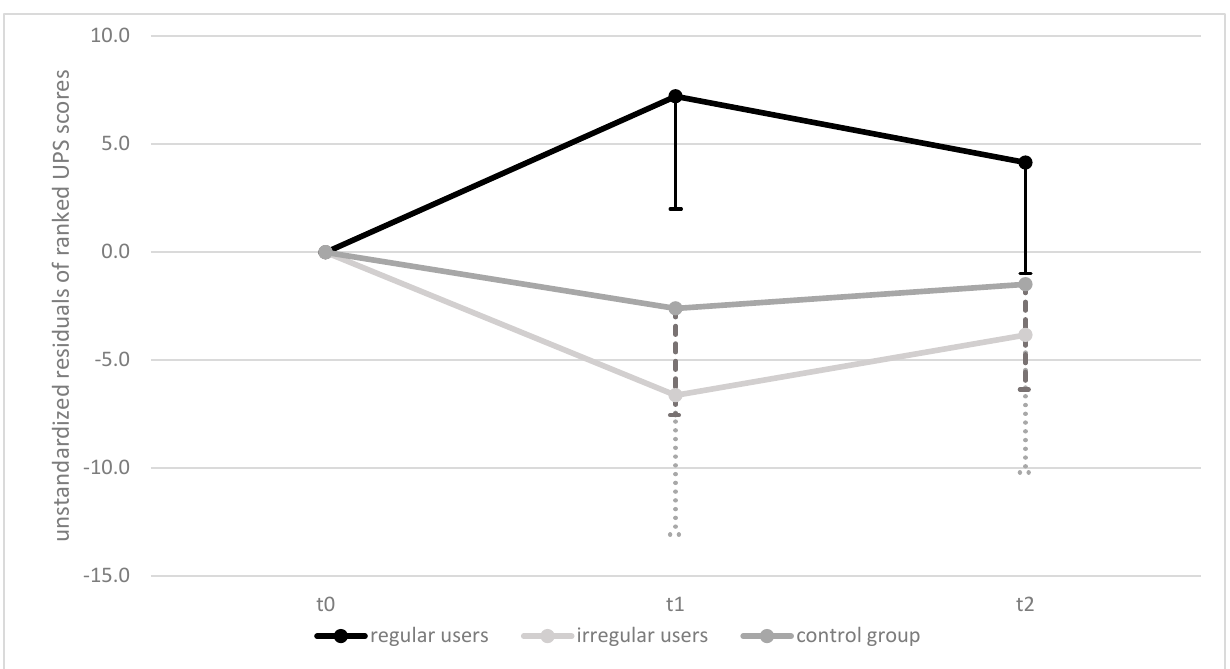
Figure 5. Mean Differences in UPS ANCOVA Results, Over Time and Between Groups/UPS = Uni Pedal Stance . Data presented as unstandardized residuals of ranked UPS scores on all three test dates adjusted for baseline scores. Error bars (one-sided): 95% CI.